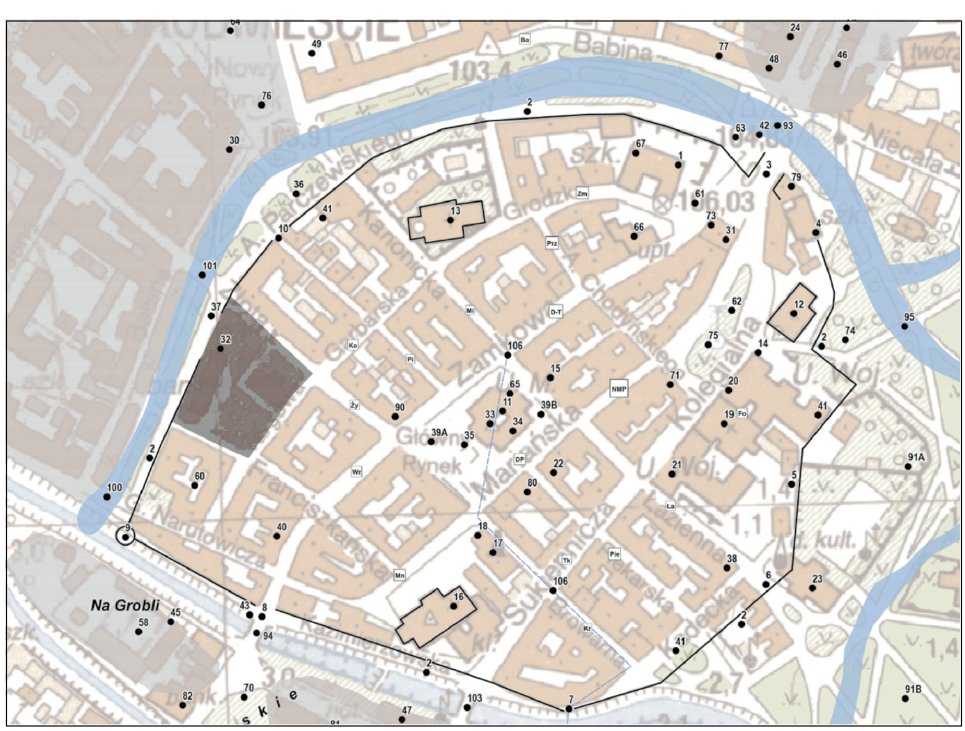
Fig. 7. Part of the map entitled “Most important buildings in the town center 13 th –20 th centuries” in the “Kalisz” volume of HTA. Many topographic features are drawn directly from the Politalski map (e.g. walls, historical river course). Source: own elaboration based on Sowina